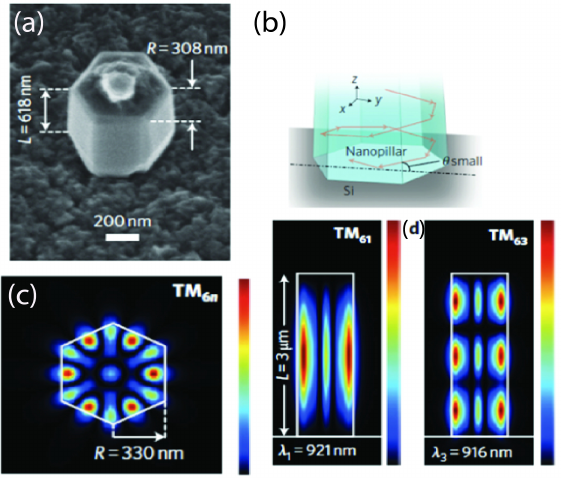
Figure 3: Helically propagating modes for optical feedback. (a) SEM image of the nanolaser grown on silicon substrate. (b) Schematic depicting a helical ray path because of glancing angle of incidence from the hexagonal facets of the nanolaser shown in (a). (c) FDTD- simulated field profile shows a hexagonal WG-like mode pattern in the transverse plane, which arises from strong azimuthal compo- nents of helical modes. (d) First-order and higher-order standing waves’ axial variation. (Reprinted with permission from Macmillan Publishers Ltd: Nature Photonics [105], ©2011.)